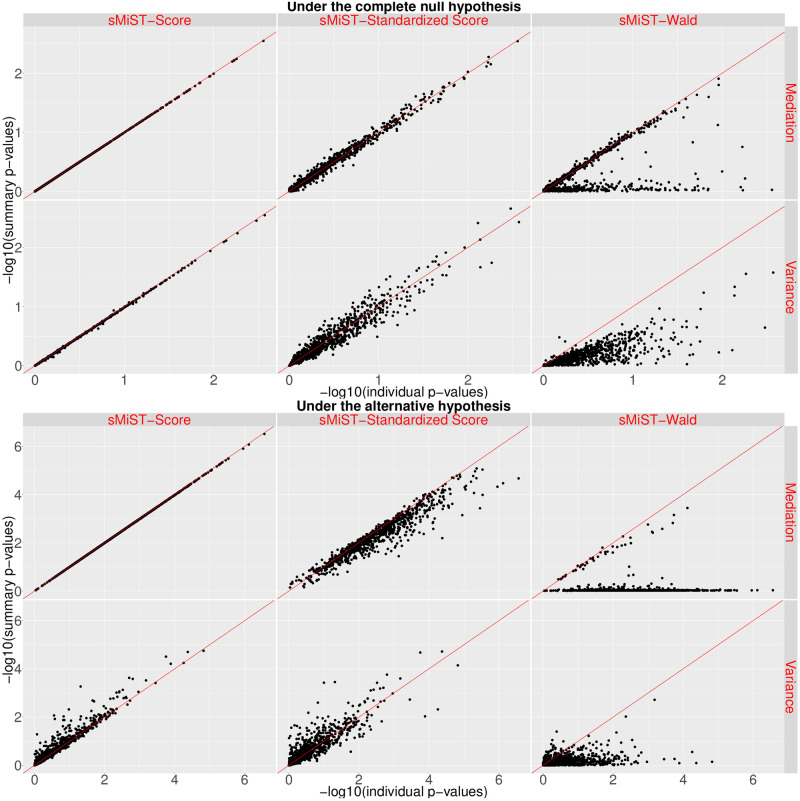
Comparison of -log10(p-values) from summary statistics based sMiST-Score, sMiST-Standardized Score, and sMiST-Wald vs. individual level data based MiST under the complete null hypothesis (top panel) and under the alternative hypothesis (bottom panel).